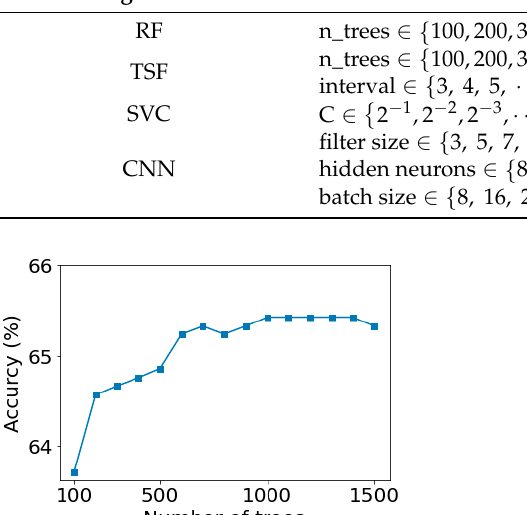
Table 1. Hyperparameter search.